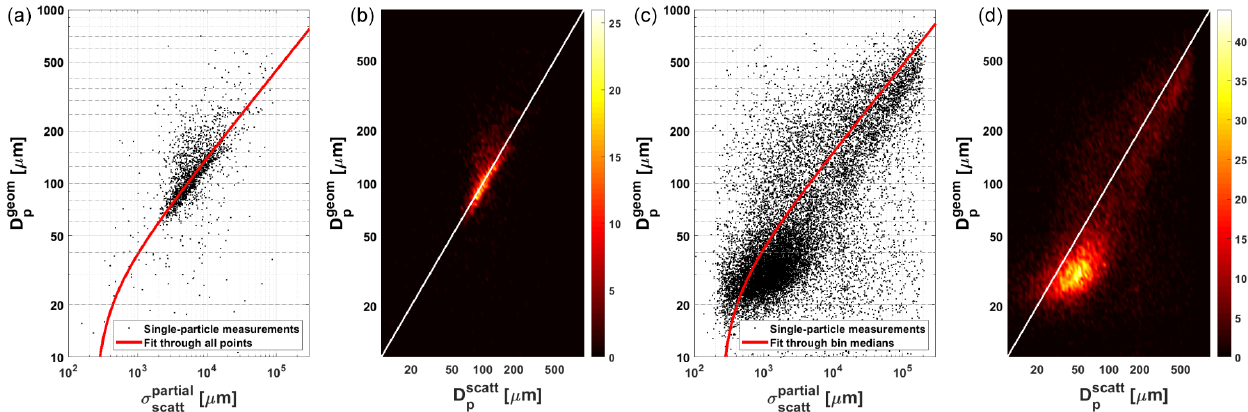
Figure 8. Calibration of the PHIPS-integrated light-scattering intensity measurement, expressed by the partial scattering cross section σ partial scatt , against the geometric diameter D geom p deduced from the concurrent stereo micrographs. Stereo micrographs from the SOCRATES data set were manually classified for droplets (a, b) and ice particles (c, d)